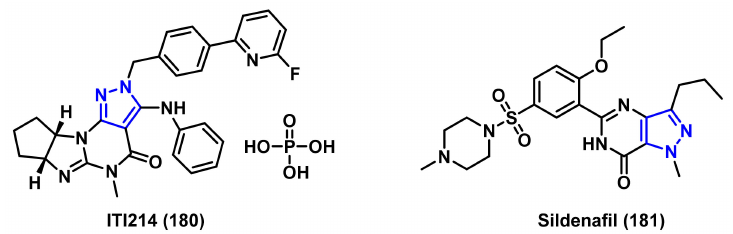
Figure 12. Chemical structures of pyrazole-containing PDE1 and PDE5